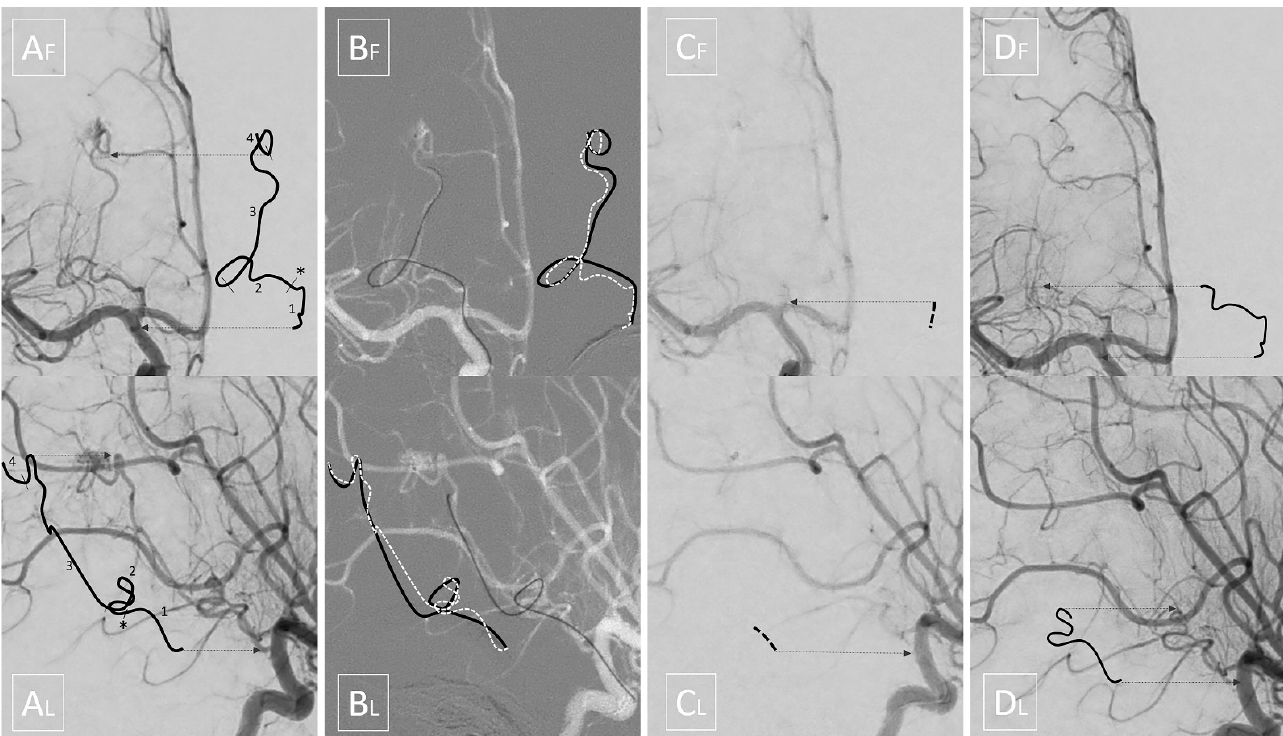
Figure 4. Upper quadrants display frontal views while lower quadrants display corresponding lateral views. Shifted lines are intended, as in Figure 1, to help the reader in localizing the intended segments. ( A ) Initial angiography: segment 1 is the cisternal portion of the anterior choroidal artery; the asterisk * corresponds to the plexal point that marks the entrance in the ventricle; segment 2 is the intraventricular segment which, in this case, is tortuous and ventrally dislocated by the tumor; segment 3 is the tumoral segment of the artery running along the surface of the tumor; segment 4 is the tumoral pedicle which penetrates the mass giving rise to the tumoral blush. ( B ) The black solid line depicts the arterial course stretched by the microcatheter, while the white dashed line depicts its anatomical course. ( C ) Panoramic angiography with the microcatheter inside the anterior choroidal artery; note that no flow is seen in the distal part of the cisternal segment of the anterior choroidal artery, and even the proximal part is barely visible. ( D ) Final angiography shows flow restored to the cisternal and intraventricular segments.